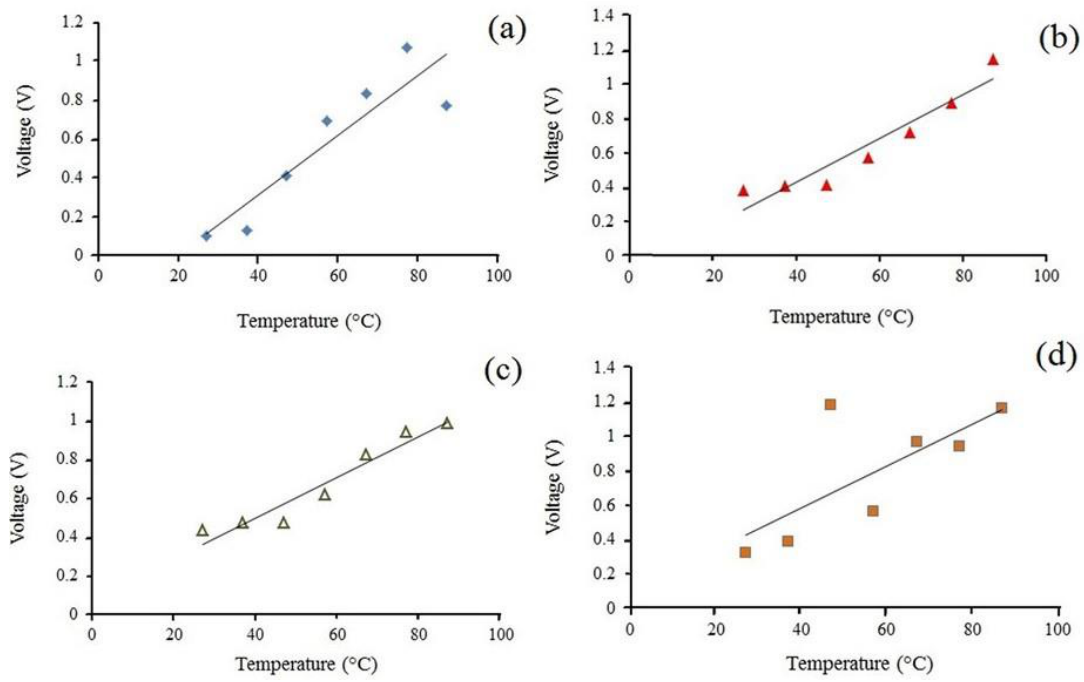
Figure 9. Comparison of output voltage for PVDF/LiCl electrospun webs when subjected to the impact test from different dropping height of ( a ) 15 cm, ( b ) 20 cm, ( c ) 25 cm, and ( d ) 30 cm at various temperatures.